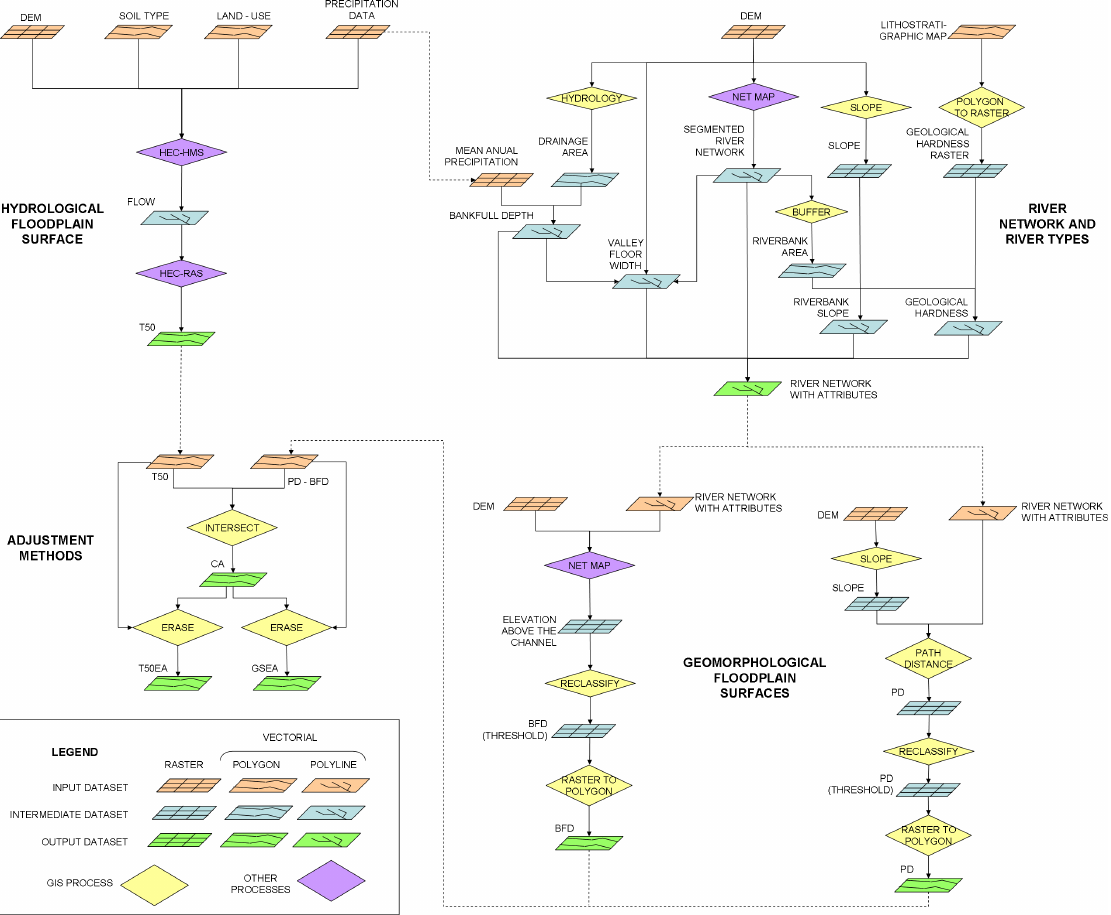
Fig. 2. Flowchart illustrating the methods used to delineate the hydrological and geomorphological floodplain surfaces and the GIS processes used to obtain coinciding and exceeding areas.